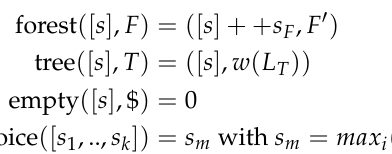
Figure A2. Scoring algebra for the Sankoff version of the small parsimony problem. Here, [ s ] is the list of scores for possible (sub)solutions and with ++ a further element is added to the